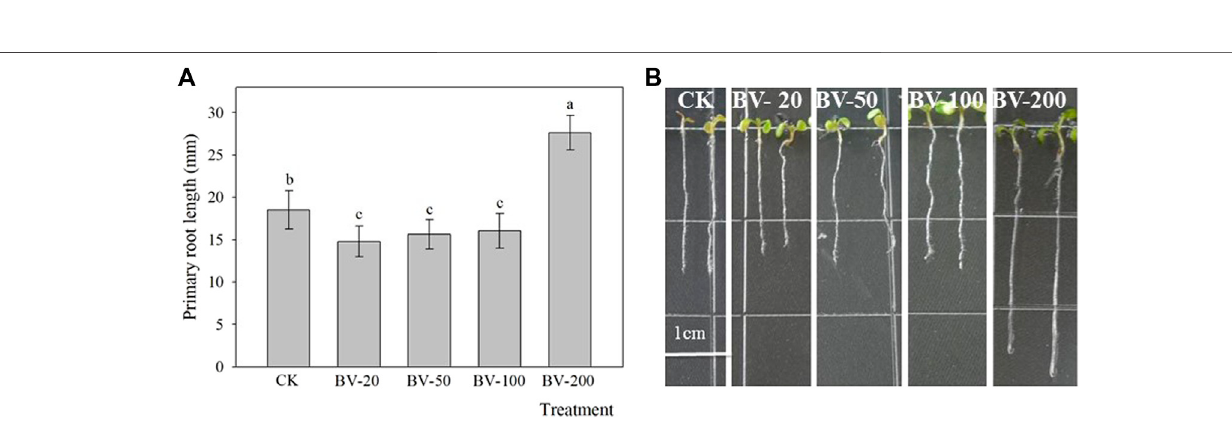
FIGURE 1 | Characterization of BV nanomaterial SEM (A) , EDS spectra (B) , and XRD patterns (C) images of BV. Arrows indicate the characteristic peak of BV.